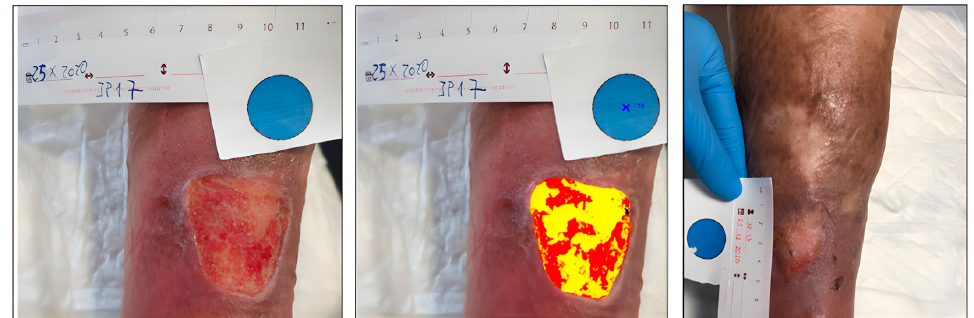
Figure 5. Healing evolution case 3: Baseline assessment ( left ), Baseline HELCOS analysis ( centre ), Week 8 assessment ( right ).